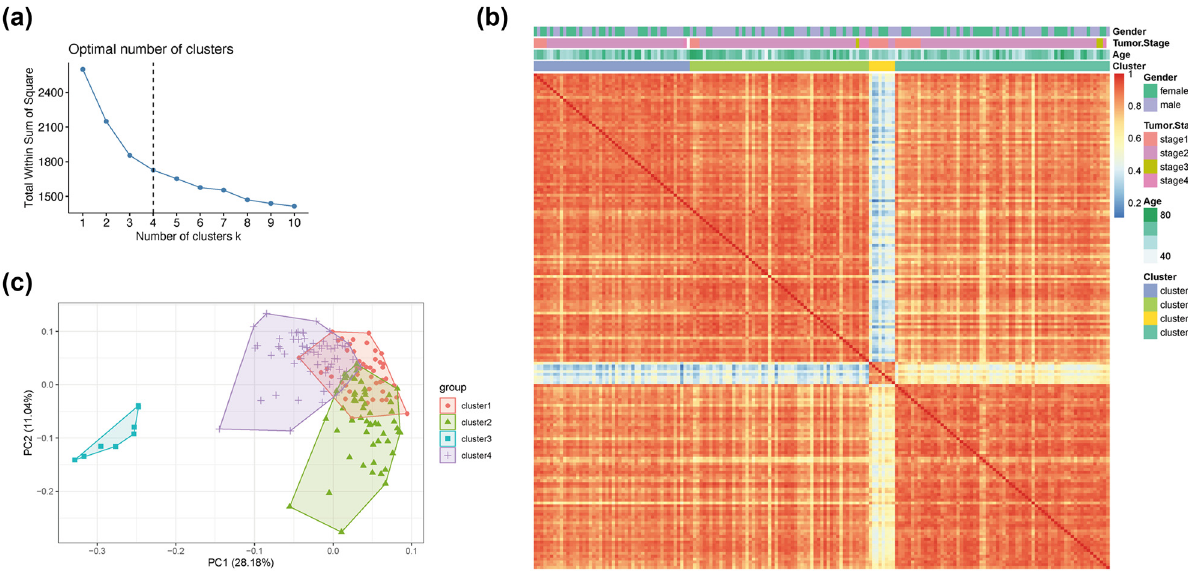
Figure 2: Unsupervised clustering of 83 drug metabolism genes: ( a ) the best type was determined; ( b ) linkage association clustering analysis ( Clusters1 – 4 ) ; and ( c ) principal components analysis ( PCA ) of subgroup